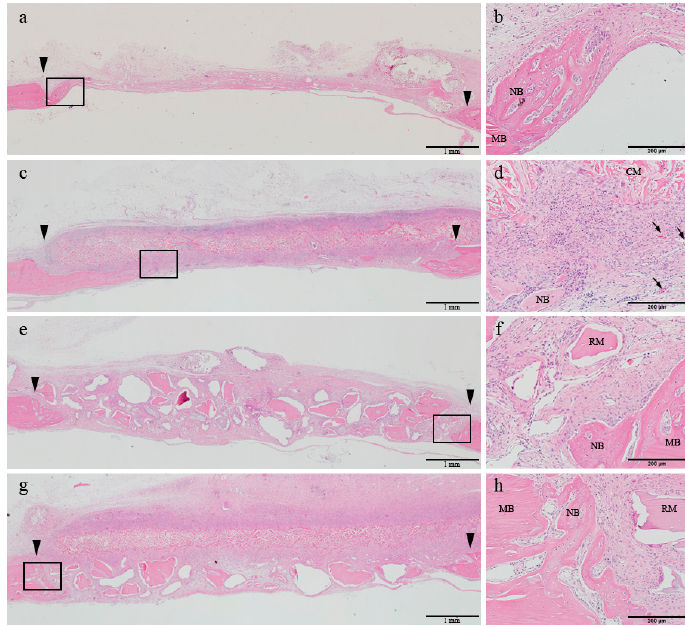
Figure 2. Histologic transversal sections obtained at 2 weeks after surgery (hematoxylin and eosin staining). ( a , b ) Control group; ( c , d ) DHT membrane group; ( e , f ) BG group; ( g , h ) DHT + BG group. The boxed areas in the left panels (40 × magnification) are magnified in the corresponding panels on the right (200 × ). Arrowhead: defect margin. MB: mother bone; NB: new bone; CM: collagen membrane; RM: residual material; black arrow: vascular endothelial cells.